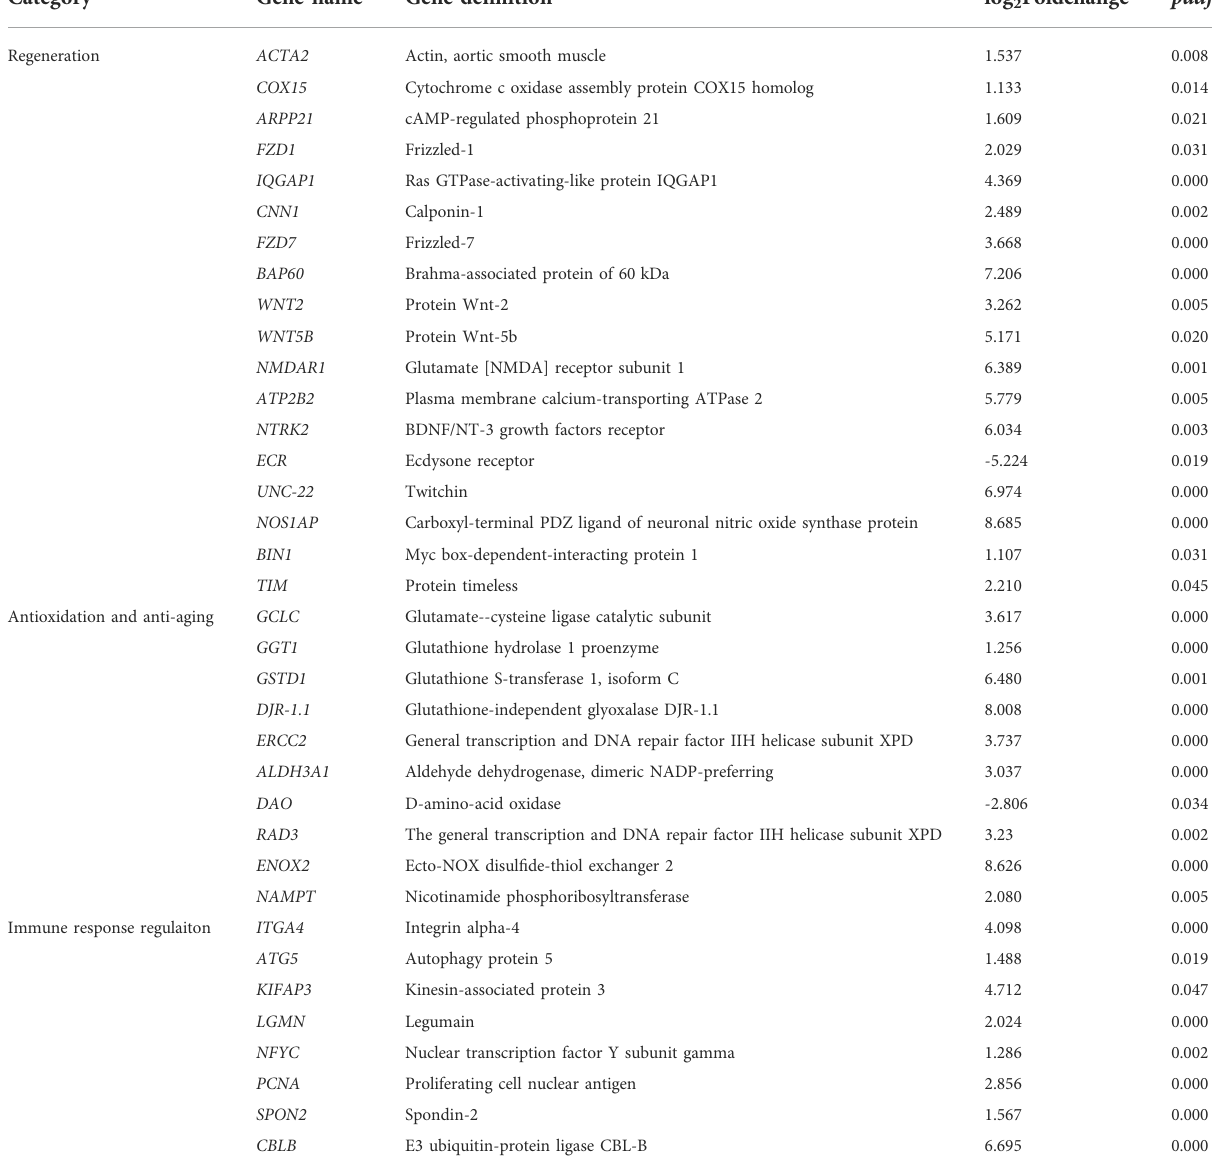
TABLE 3 Key DEGs in heart transcriptome of E. sinensis .